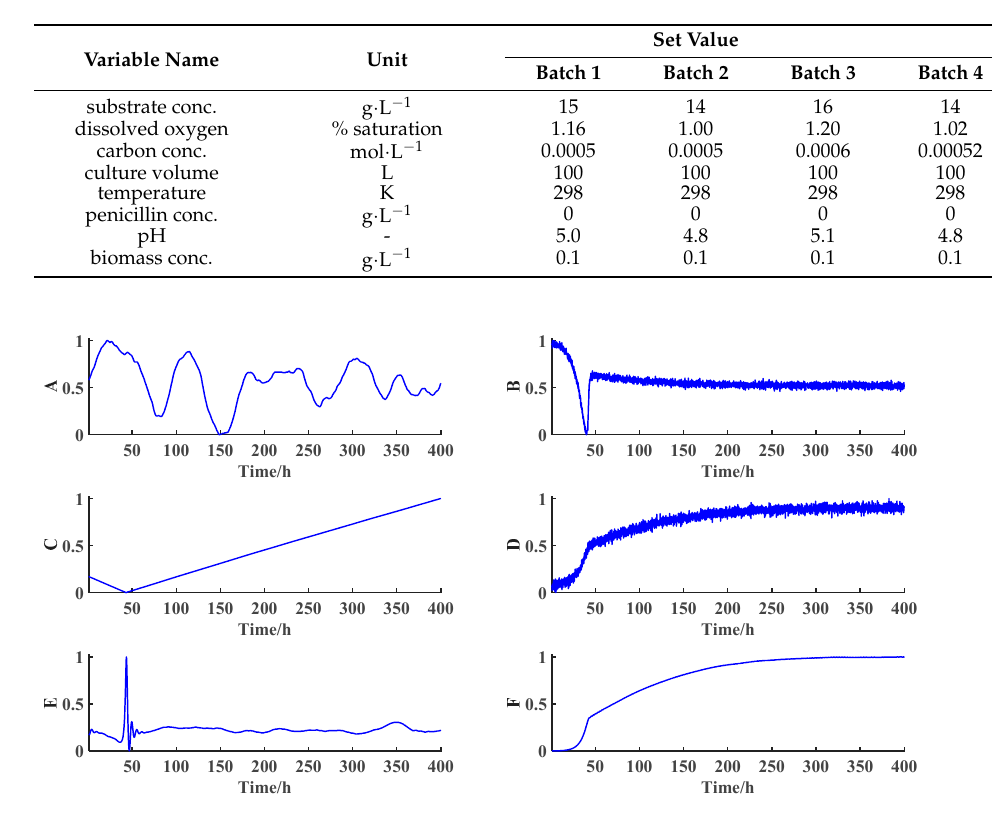
Figure 5. The diagnostic variables trend of a normal sample obtained by running PenSim based on the settings of batch 1. A: the flow of air; B: dissolved oxygen concentration; C: real volume of fermentation liquid; D: carbon dioxide concentration; E: pH value; F: cold water flow.